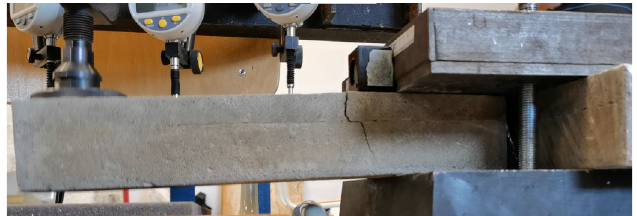
Figure 25. Delamination of specimen 22030420 after load test (composite FC and CC).